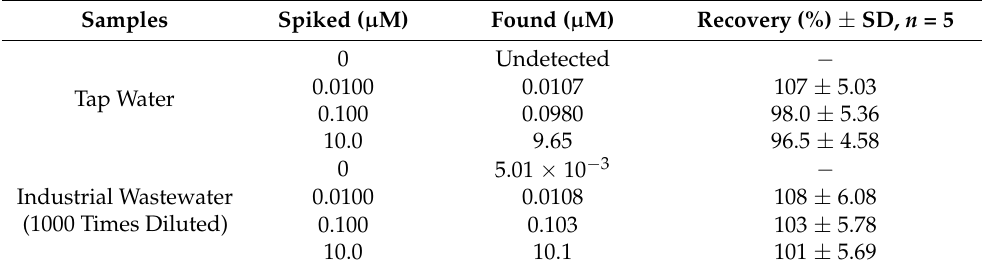
Table 2. Recovery results by using as-proposed colorimetric sensor.